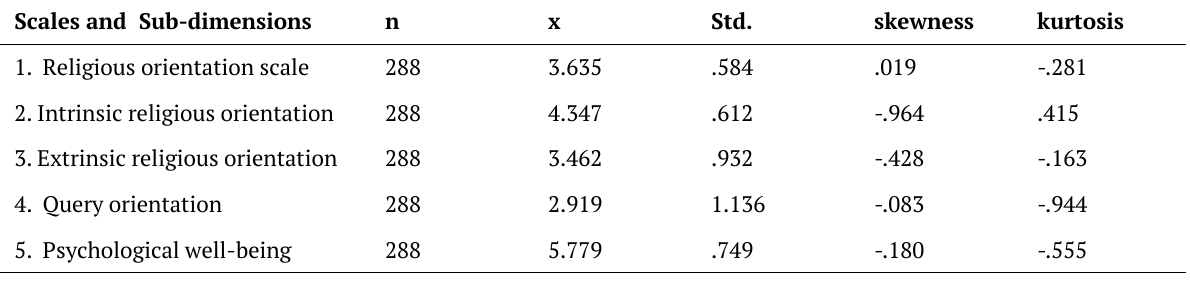
Table 1. Descriptive Statistics Results of the Study Scales and Sub-dimensions